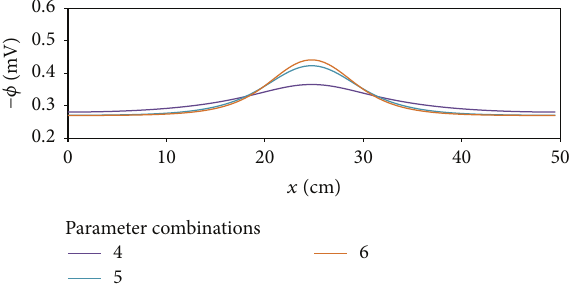
Figure7:Electricalpotentialprofileonconcretesurfacefordifferent corrosion intensities.